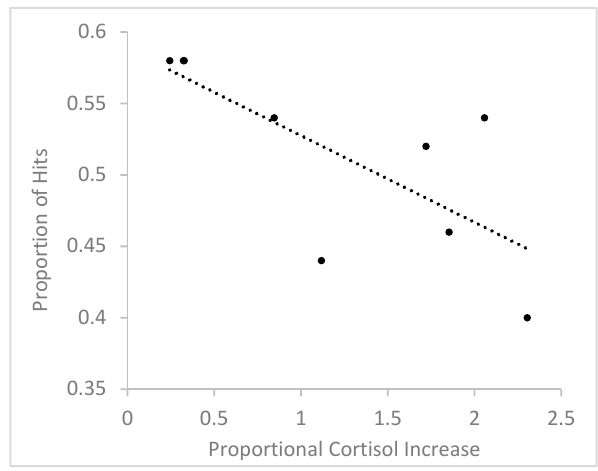
Figure 5. Relationship between relative cortisol increase and proportional hit rate in male responders.